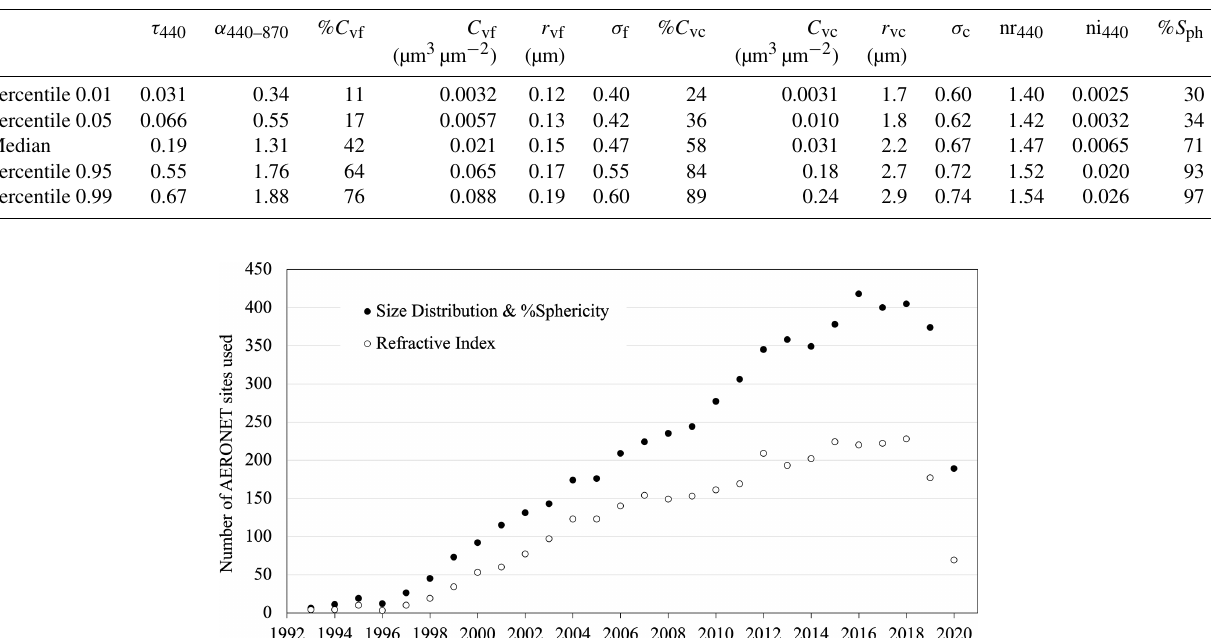
Table 2. Same as Table 1 but by affecting one median value of each microphysical parameter per AERONET site and then by deriving the median value of the 851 sites (400 for refractive index) for each microphysical parameter.